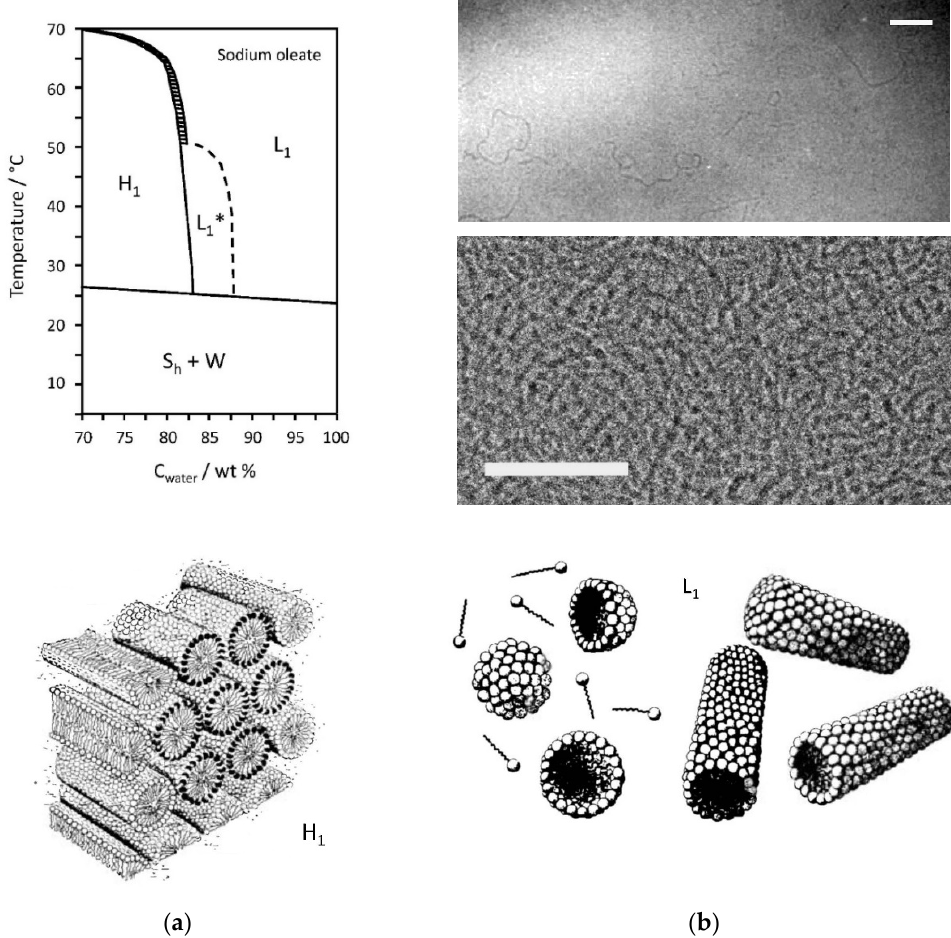
Figure 3. Aqueous dispersions of sodium oleate and water. ( a ) Top : Partial temperature–composition phase diagram, reproduced from Antunes et al. (2007) [47], as mirror image of the originally published diagram; L 1 : micellar solution (consisting of spherical and flexible cylindrical, wormlike micelles); L 1 *, viscous micellar solution (consisting of entangled wormlike micelles [52]); H 1 , hexagonal liquid crystalline phase (consisting of long cylindrical micelles lying parallel to each other and arranged in a hexagonal lattice); (S h + W), hydrated oleate crystals plus water; dashed area, coexistence of L 1 and H 1 . Bottom : Schematic representation of a hexagonal liquid crystalline phase, H 1 [53]. ( b ) Top : Cryo-TEM image of a 3.6 mM sodium oleate solution (=0.11 wt%) at pH = 10.7, quenched from T = 25 °C (bar: 100 nm), showing long cylindrical oleate micelles, reproduced from Edwards et al. (1995) [51]. Middle : Cryo-TEM image of a 0.45 M sodium oleate dispersion (=13 wt%), quenched from T = 25 °C (bar: 50 nm), showing mostly wormlike micelles, reproduced from Tatini et al. (2021) [52]. Bottom : Schematic representation of a spherical and cylindrical (worm-like) micelles [53]. Reproduced with permission from [47], Elsevier, 2007; from [53], Society of Cosmetic Chemists, 1968; from [51], American Chemical Society, 1995; and from [52], Elsevier, 2021.